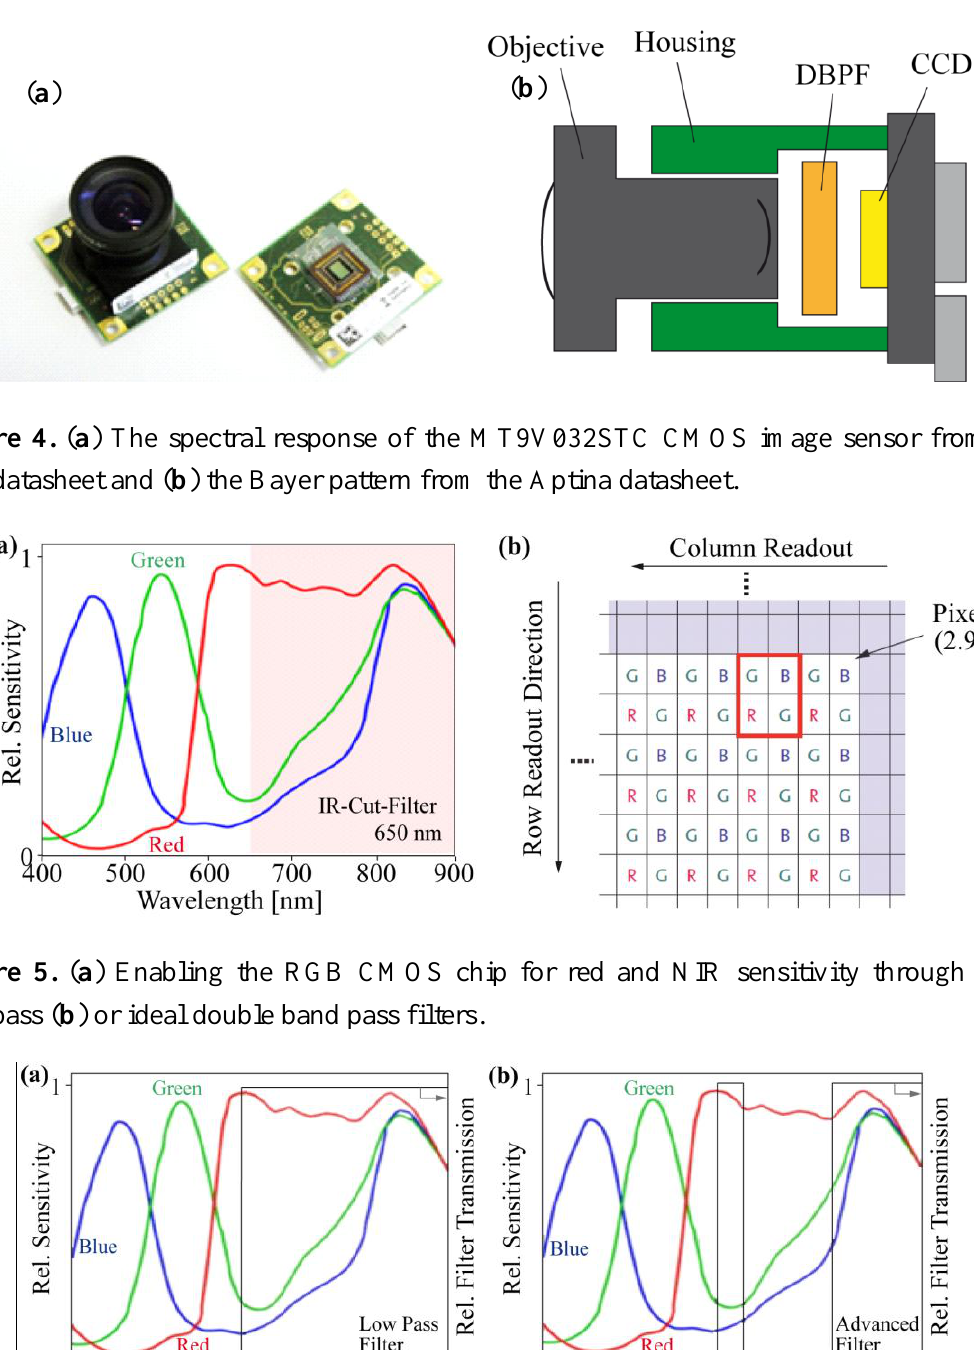
Figure 3. ( a ) IDS uEye camera: USB UI-1226LE-M/-C and ( b ) the outline for the setup with the implemented double band pass filter (DBPF).